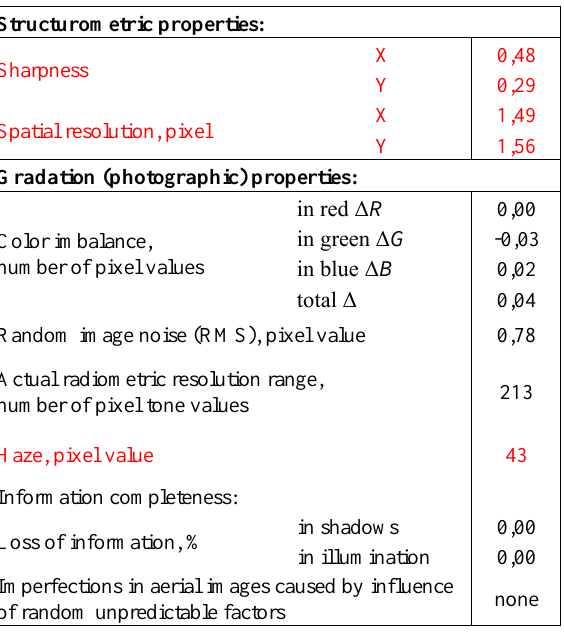
Table 2. The quality assessment results of image with poor visual quality, shown in Figure